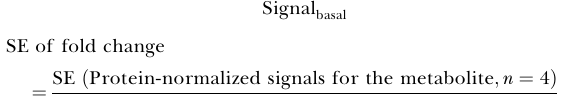
Figure S1. DNA Content of Actively Growing or Quiescent Cells Found at doi:10.1371/journal.ppat.0020132.sg001 (57 KB PPT). Figure S2. Isotope-Labeled Internal Standard Controls Isotope-labeled internal standards were added to mock- (dotted line) and HCMV-infected (red line) samples prior to measurement as described in Materials and Methods. Average SRM peak heights ( n ¼ 4) and the standard error of their means were plotted relative to the mock 4-hr internal standards on a log 2